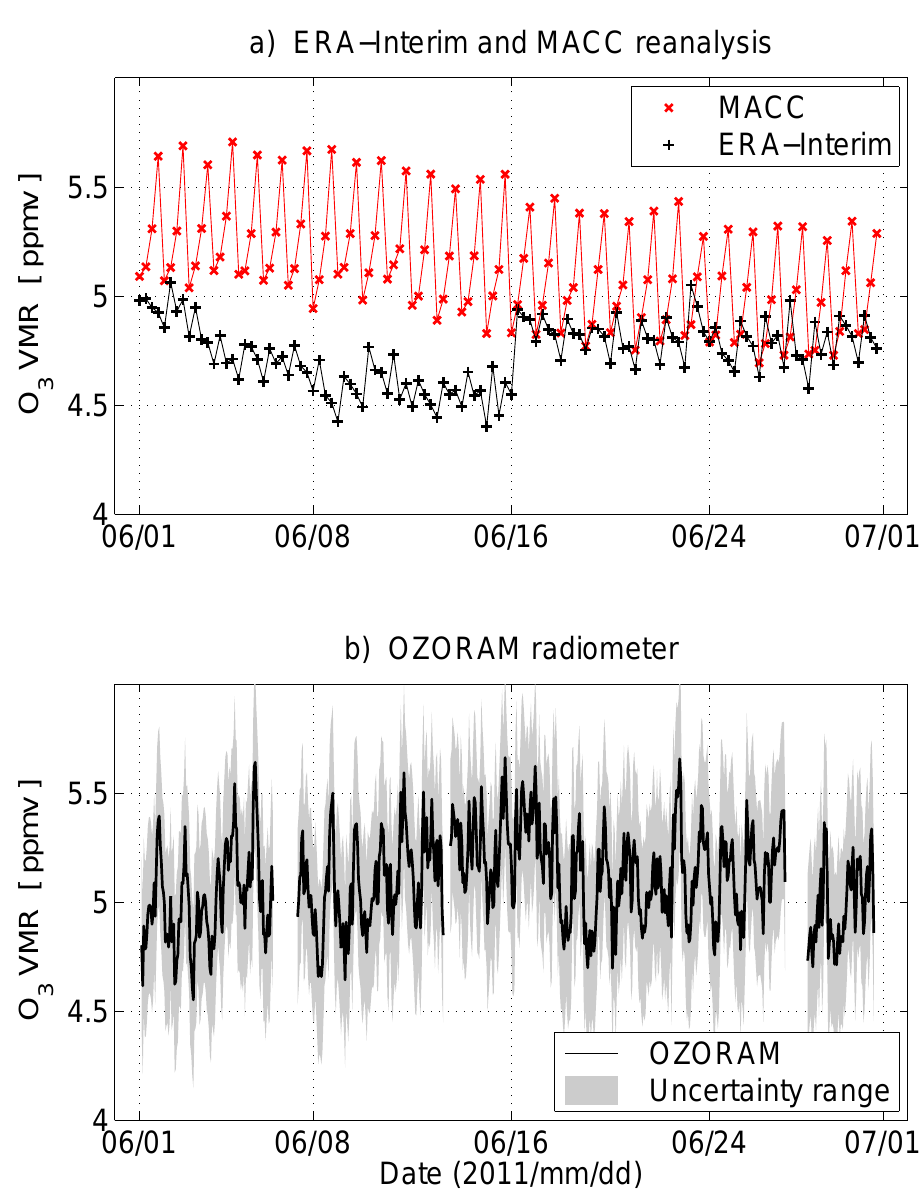
Figure 7. Ozone time series from MACC reanalysis and ERA-Interim ( a ) and OZORAM ( b ) during June 2011 at 3 hPa (40 km) over Ny-Ålesund, Svalbard (78.9 ◦ N, 11.9 ◦ E). The uncertainty range stands for the combined random and systematic standard